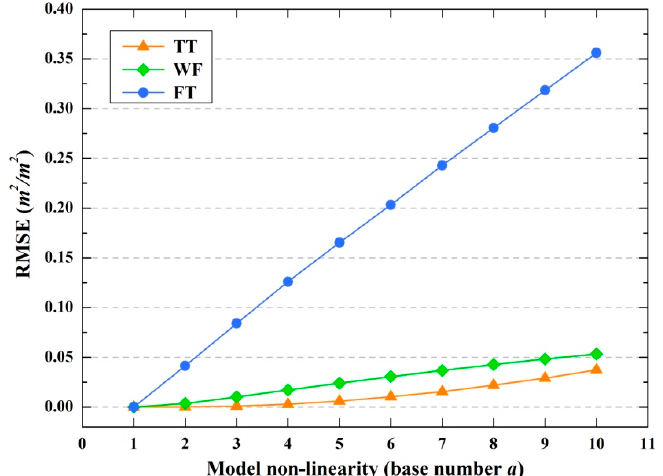
Figure 6. Correction of the scaling bias caused by model non-linearity using the three techniques TT, WF, and FT. The non-linearity of LAI estimation model ( LAI = a NDVI ) was represented by the base number a .